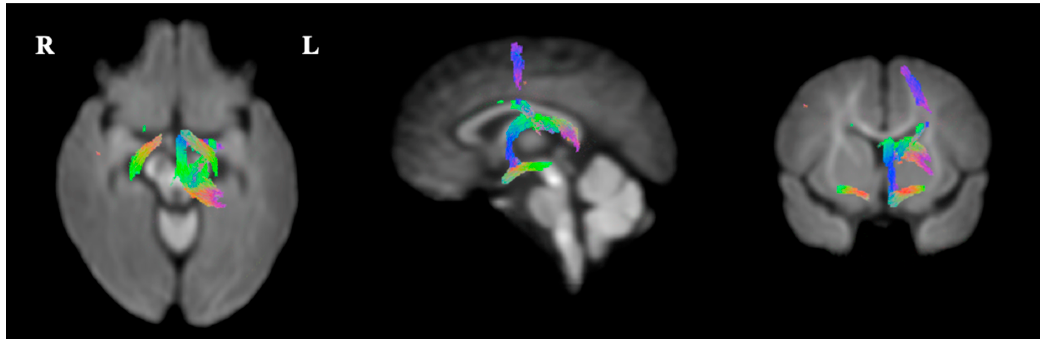
Figure 6. Presentation of the FBA results expressing the effect sizes as a relative increase (from red to yellow, indicating 0% to 30% difference) in fiber-bundle cross-sections in the TAU group relative to the CBT group, in children aged approximately six years, in a longitudinal study built on a pilot Randomized Controlled Trial comparing Cognitive Behavioral Therapy (CBT, n = 8) and Treatment as Usual (TAU, n = 8) for maternal antenatal depression. The Fornix and Optic Tract showed an increase of 10–20%, and the Stria Terminalis showed an increase of 20–25% in fiber-bundle cross- section in the TAU group compared to the CBT group. 4. Discussion We performed a longitudinal brain MRI study in 6-year-old children, built on a prior pilot RCT comparing Cognitive Behavioral Therapy (CBT) and Treatment as Usual (TAU) for maternal antenatal depression. We found no robust evidence for a treatment effect of CBT for